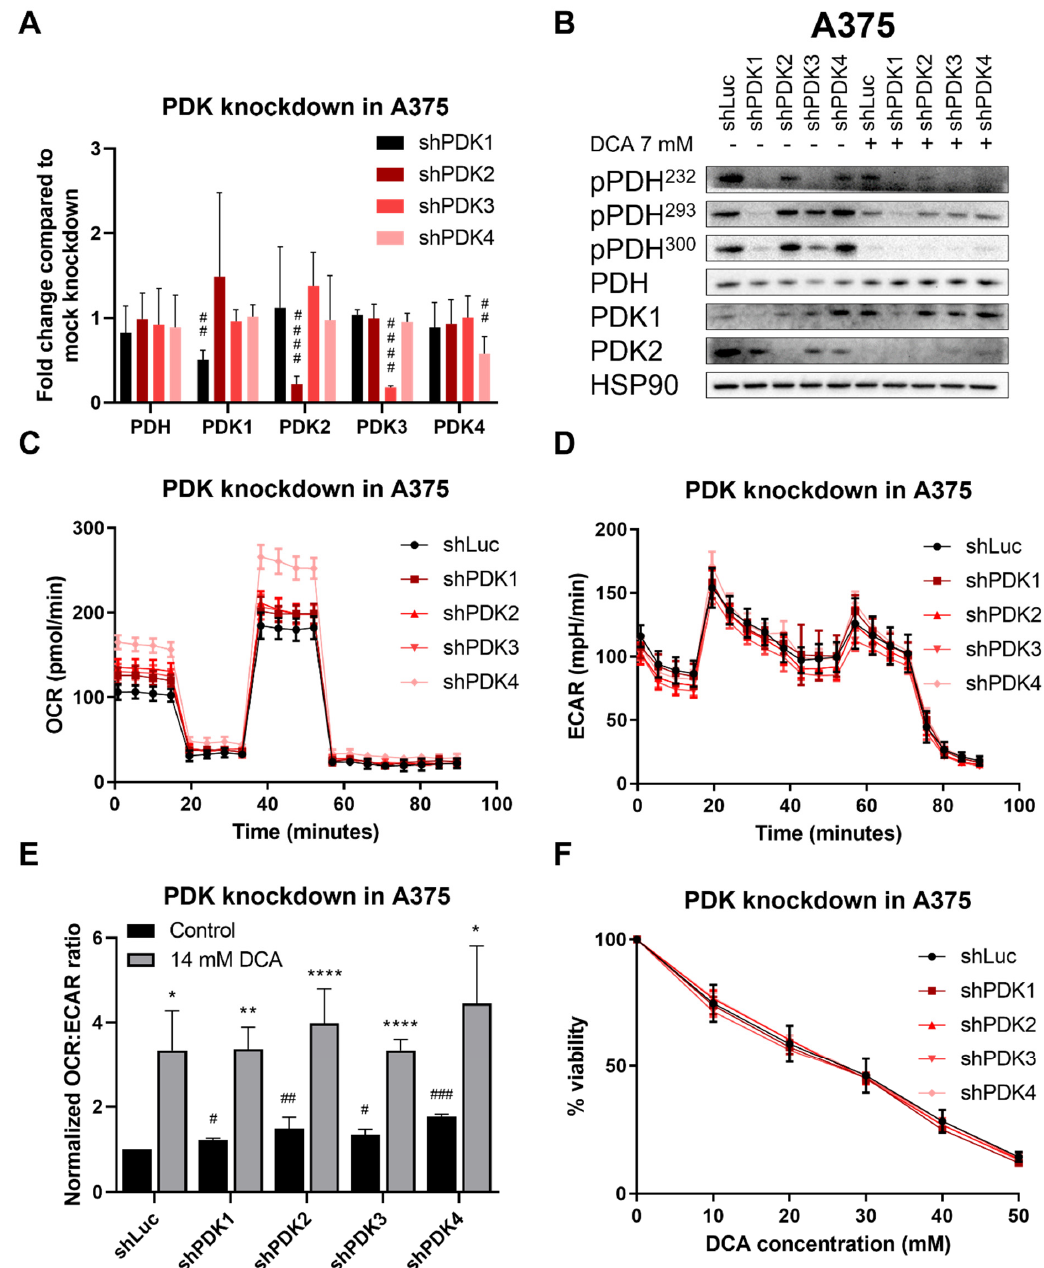
Figure 4. Effect of PDK knockdown on RNA levels, protein levels and viability under DCA treatment. ( A ) Fold change in RNA levels of PDH and PDK1-4 after PDK knockdown compared to the mock knockdown. Data represent mean ± SD of 3 independent experiments, each performed in quadruplicate. One-way ANOVA followed by Dunnett’s multiple comparison test, ## p < 0.01, #### p < 0.0001, shPDK1-4 vs. shLuc. ( B ) Representative image of protein levels after PDK knockdown and/or DCA treatment. ( C ) Representative image of OCR in PDK knockdown cell lines measured by Seahorse, mean ± SD of 6–8 technical replicates are shown. ( D ) Representative image of ECAR in PDK knockdown cell lines measured by Seahorse, mean ± SD of 6–8 technical replicates are shown. ( E ) PDK knockdown increases the OCR:ECAR ratio, whereas OCR:ECAR ratio is even further increased after DCA treatment in all knockdowns. Data represent mean ± SD of 3 independent experiments, each consisting of 6–8 replicates. One-way ANOVA followed by Dunnett’s multiple